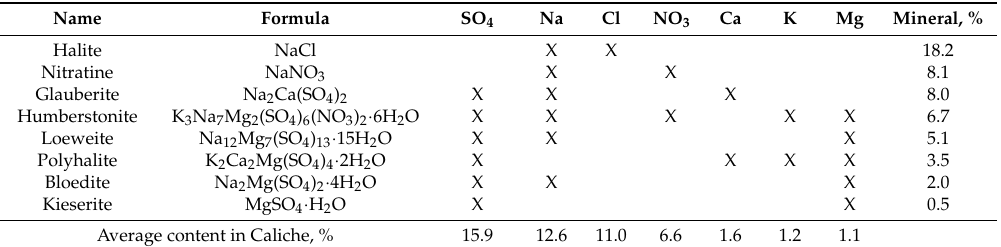
Table 1. Chemical and mineral composition of the soluble fraction of caliche ore used in the leaching experiments.